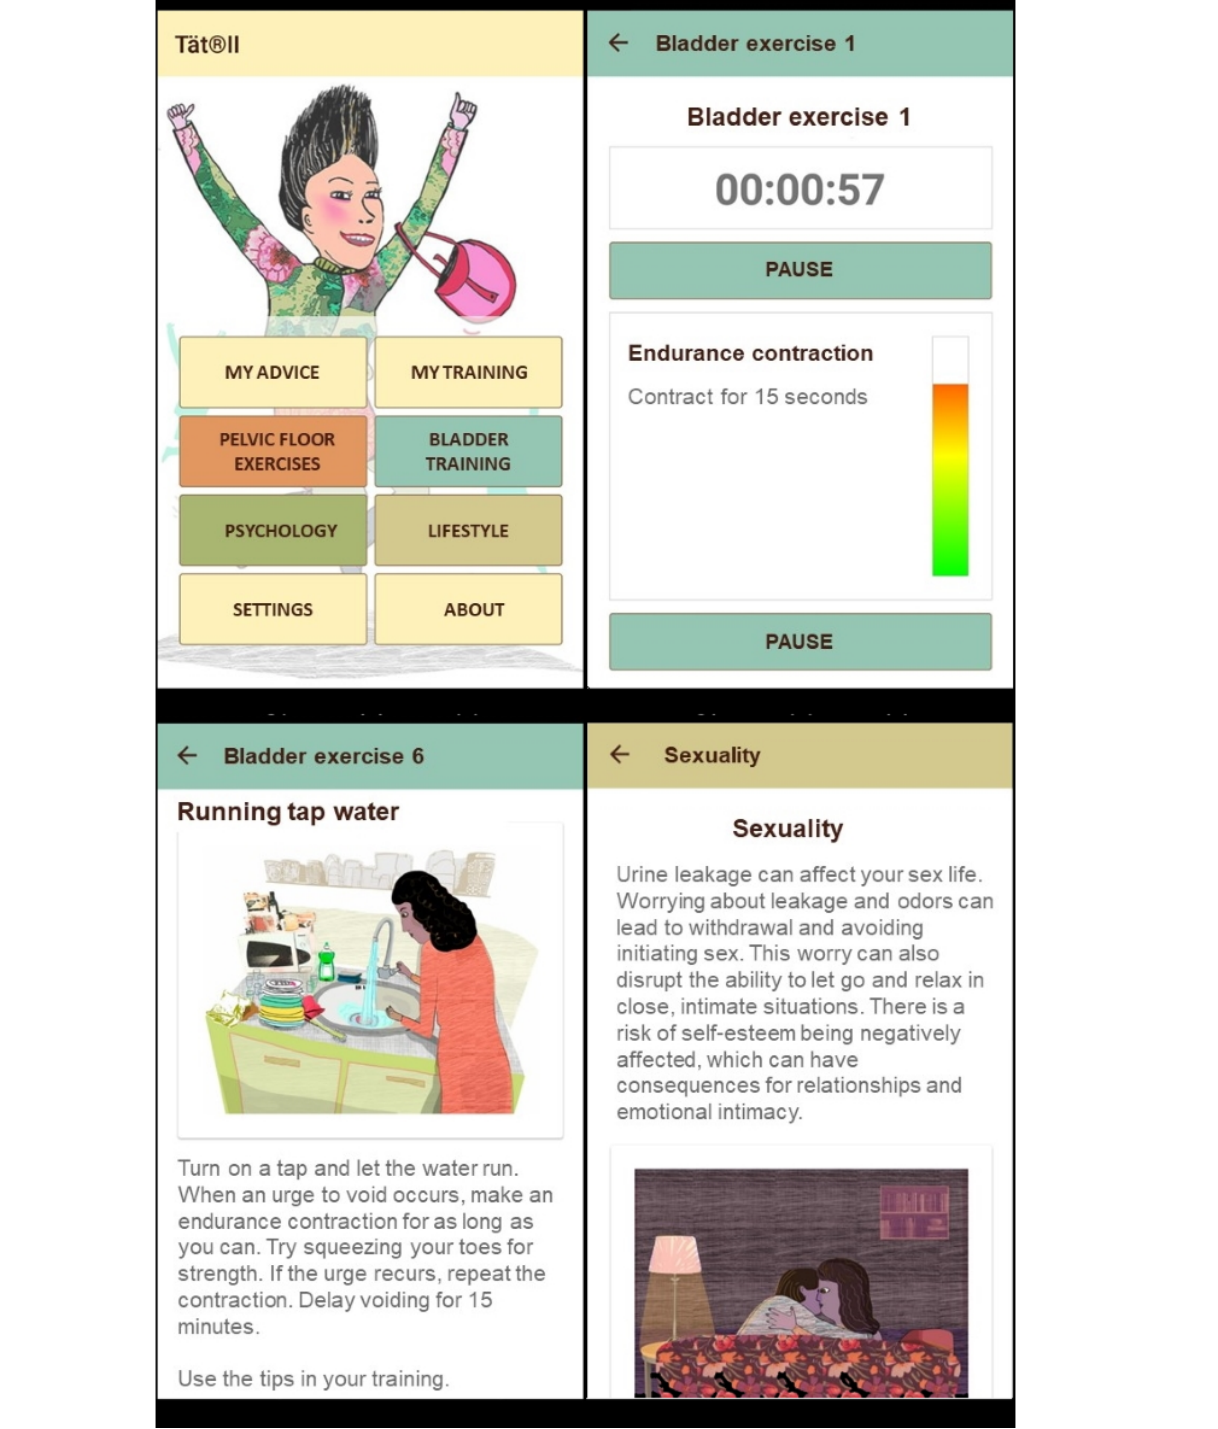
Figure 1. Screenshots from the treatment app (Tät II). Upper-left corner: main (home) screen; upper-right corner: active view of an exercise in the bladder training program; lower-left corner: textual description of another bladder training exercise; lower-right corner: information from the lifestyle section. Text has been translated from Swedish to English for illustration